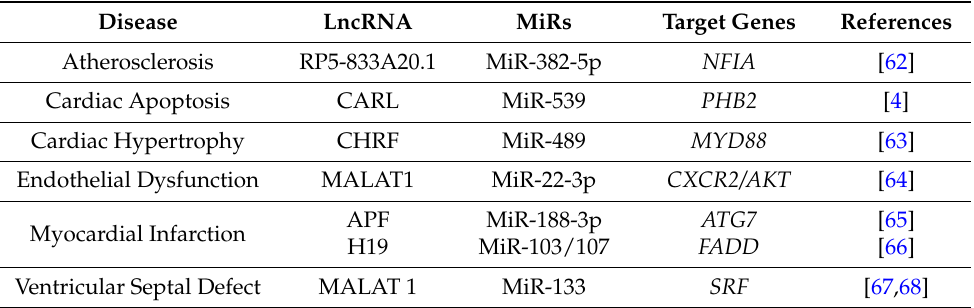
Table 2. Identification of long noncoding RNA-microRNA-target gene axis in cardiovascular